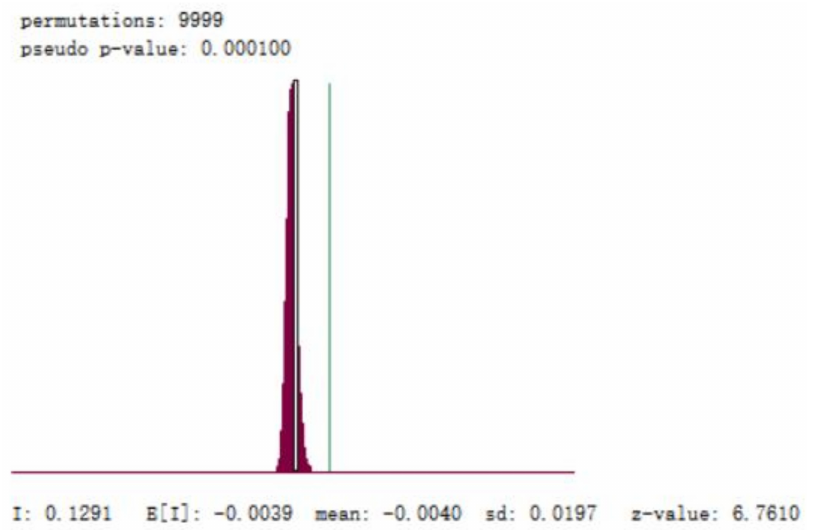
Figure 4. Z-score score chart of the cumulative number of COVID-19 on 8 April 2020.